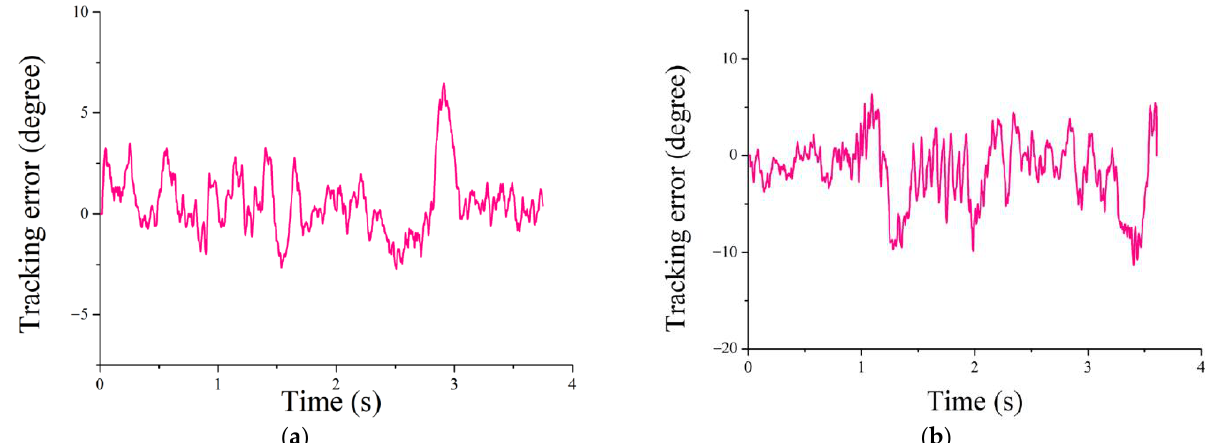
Figure 20. Tracking error of the ( a ) hip and ( b ) knee by the conventional controller.